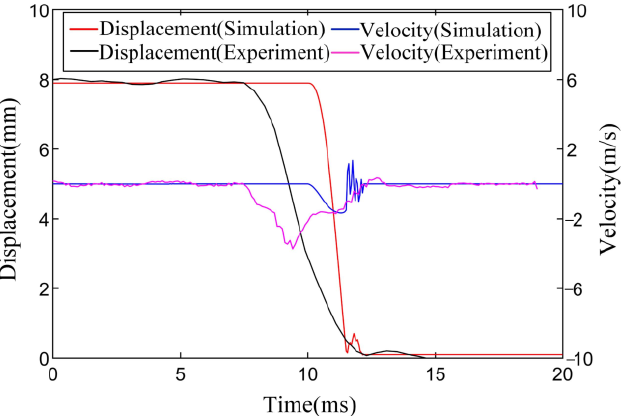
Figure 5. Comparison curves of the valve between experiment and simulation.